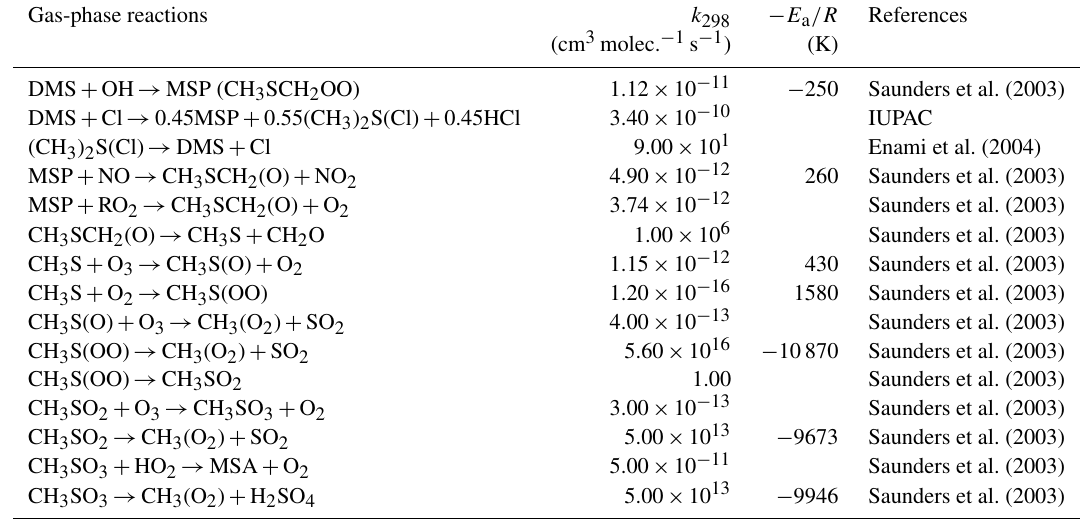
Table 4. Summary of the MSA-producing branch of the H-abstraction pathway in the DMS chemistry implemented into